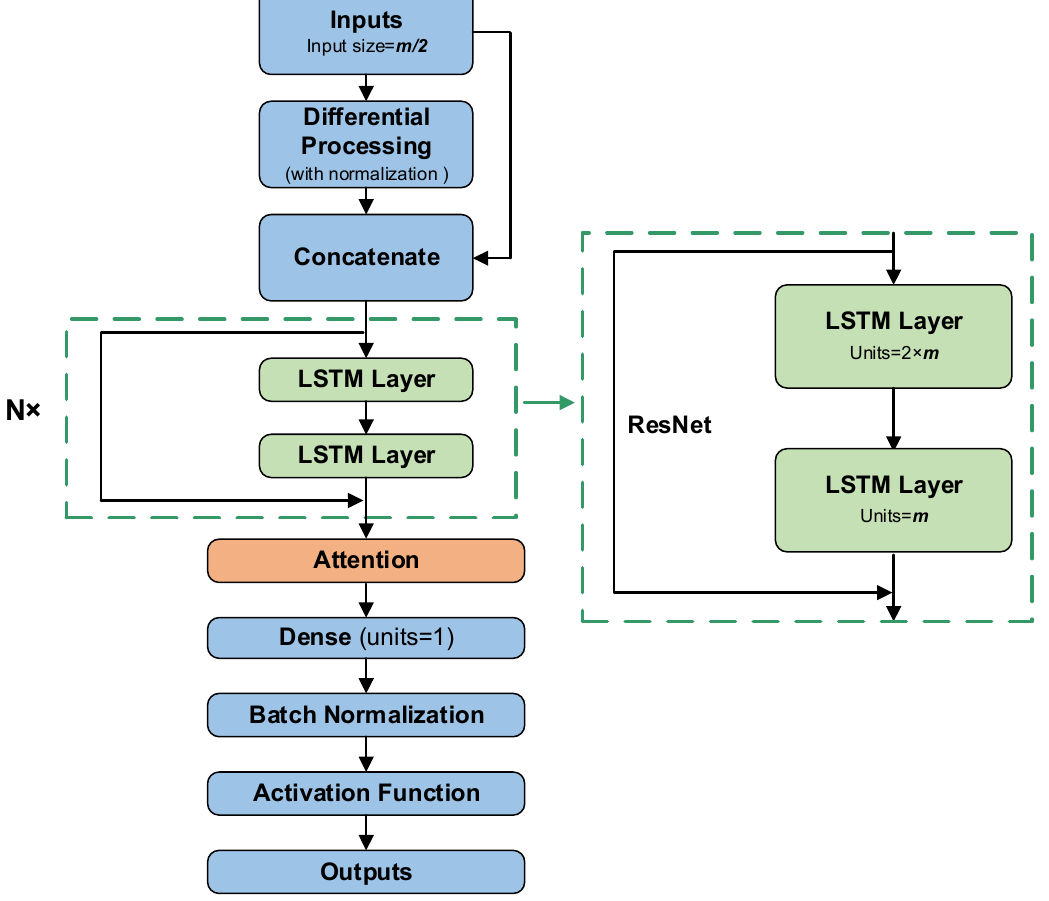
Figure 7. The structure of the prediction